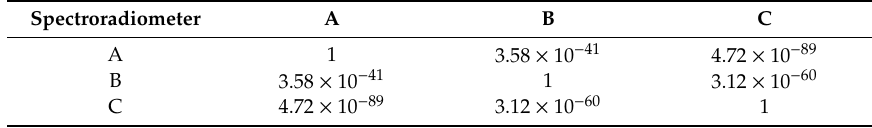
Table 1. T -Test ( p -value) of spectroradiometer data for study areas (age categories) A, B, C.